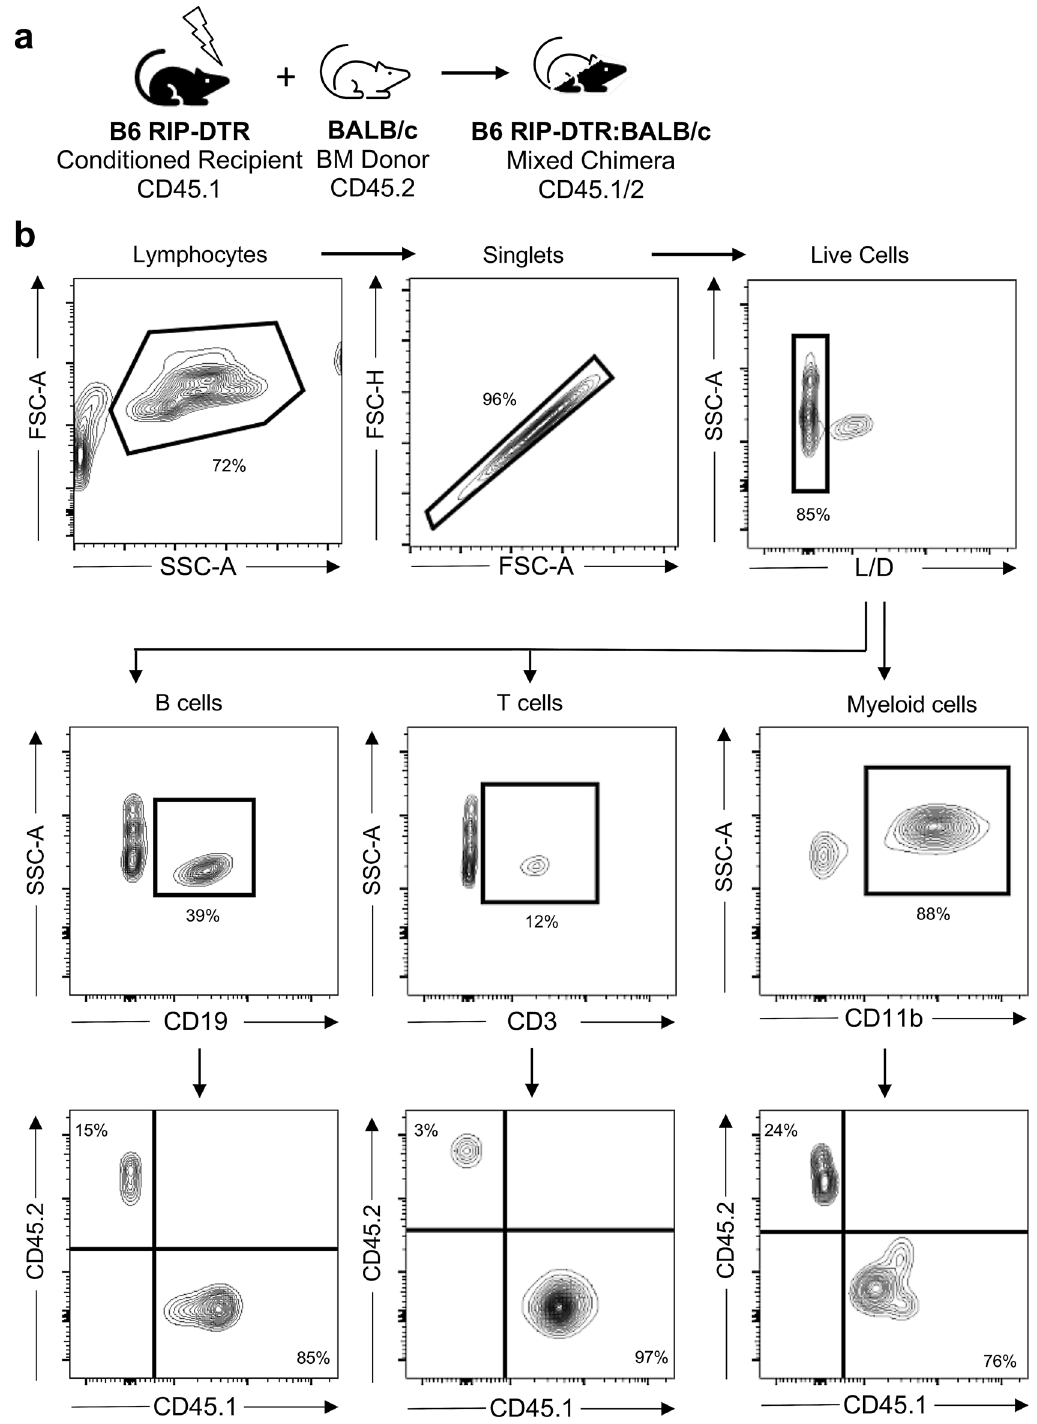
Figure 1. Phenotyping of CD45 in B6 RIP-DTR mice with BALB/c mixed chimerism. ( a ) Schematic showing generation of mixed chimerism in B6 RIP-DTR mice (CD45.1) using bone marrow (BM) from BALB/c CD45.2 donors. ( b ) Representative flow analysis of peripheral blood from a B6 RIP-DTR mixed chimera at 8 weeks after hematopoietic cell transplant with 1.5 × 10 6 CD45.2 BALB/c donor hematopoietic cells. Live single cells are gated on CD19 to distinguish B cells, CD3 to distinguish T cells, or CD11b to distinguish myeloid cells, which are subsequently gated on CD45.1 and CD45.2 to distinguish host and donor